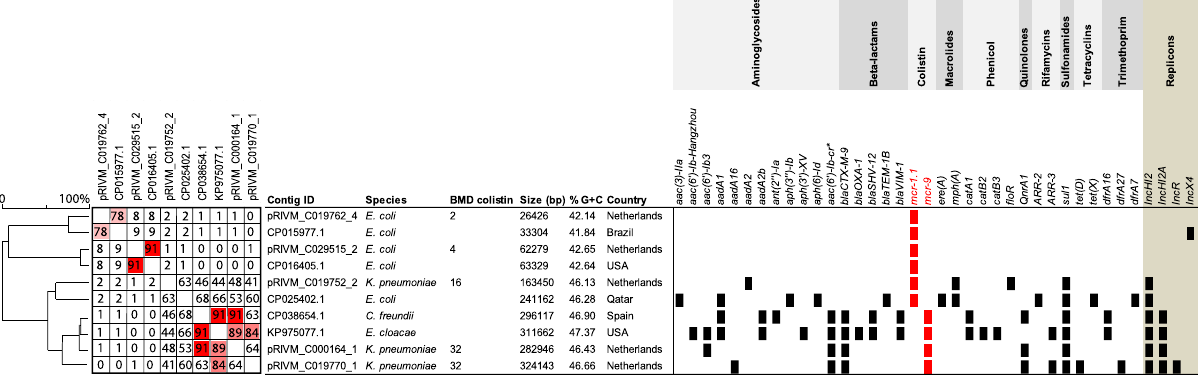
Fig. 4 Comparison of plasmids containing mcr genes. Contig IDs that start with ‘ pRIVM ’ are from plasmids of isolates collected in the current study. The other isolates are the closest resembling plasmids from the NCBI database. Percentages identity are depicted in the square on the left. Source data: Supplementary Data fi le 4 and GenBank of the National Centre for Biotechnology Information (BioProject ID PRJNA754858). BMD: broth microdilution, bp: base pairs, USA: United States of America, % G + C: guanine-cytosine